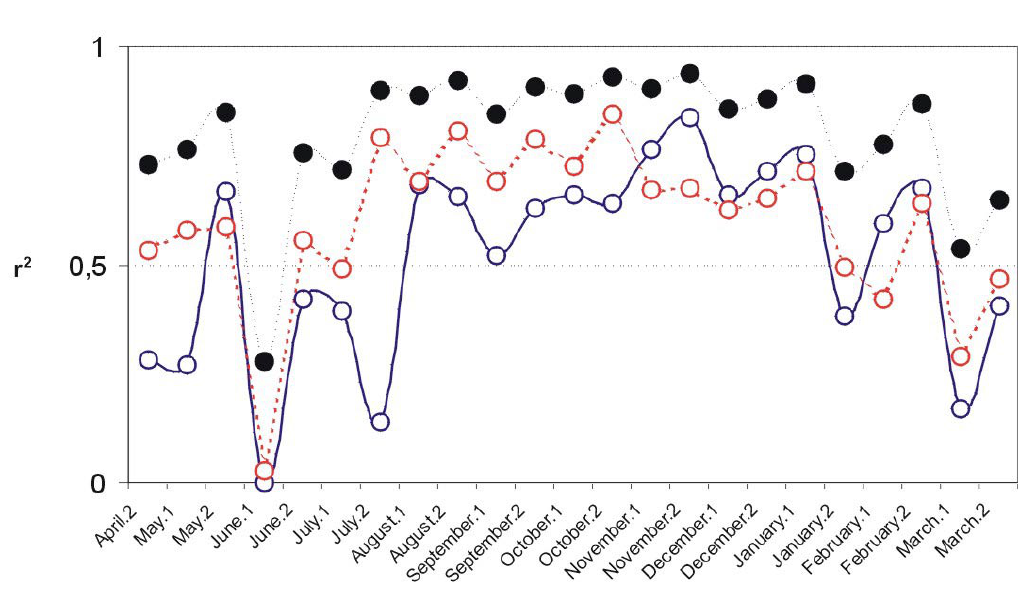
FIGURE 7 . R 2 of the Table 2 regressions throughout the sampling period: distance (red circle), elevation (blue circle), and combination of both (black